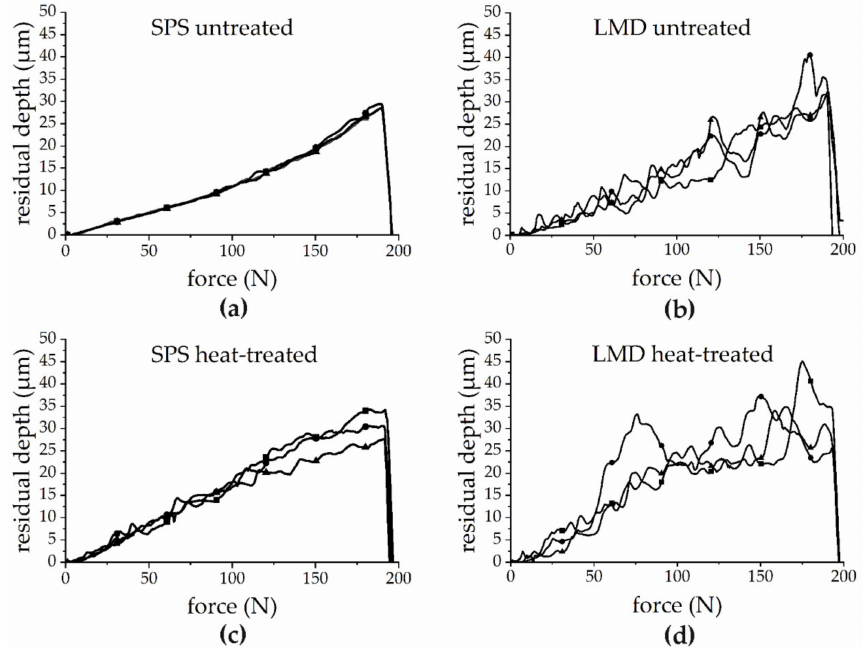
Figure 10. Progressive load scratch testing of ( a ) untreated and ( c ) heat-treated SPS bulk material as well as ( b ) untreated and ( d ) heat-treated LMD coating. The straight line gradient of the SPS bulk materials suggests a high surface quality with a low number of pores and cracks.